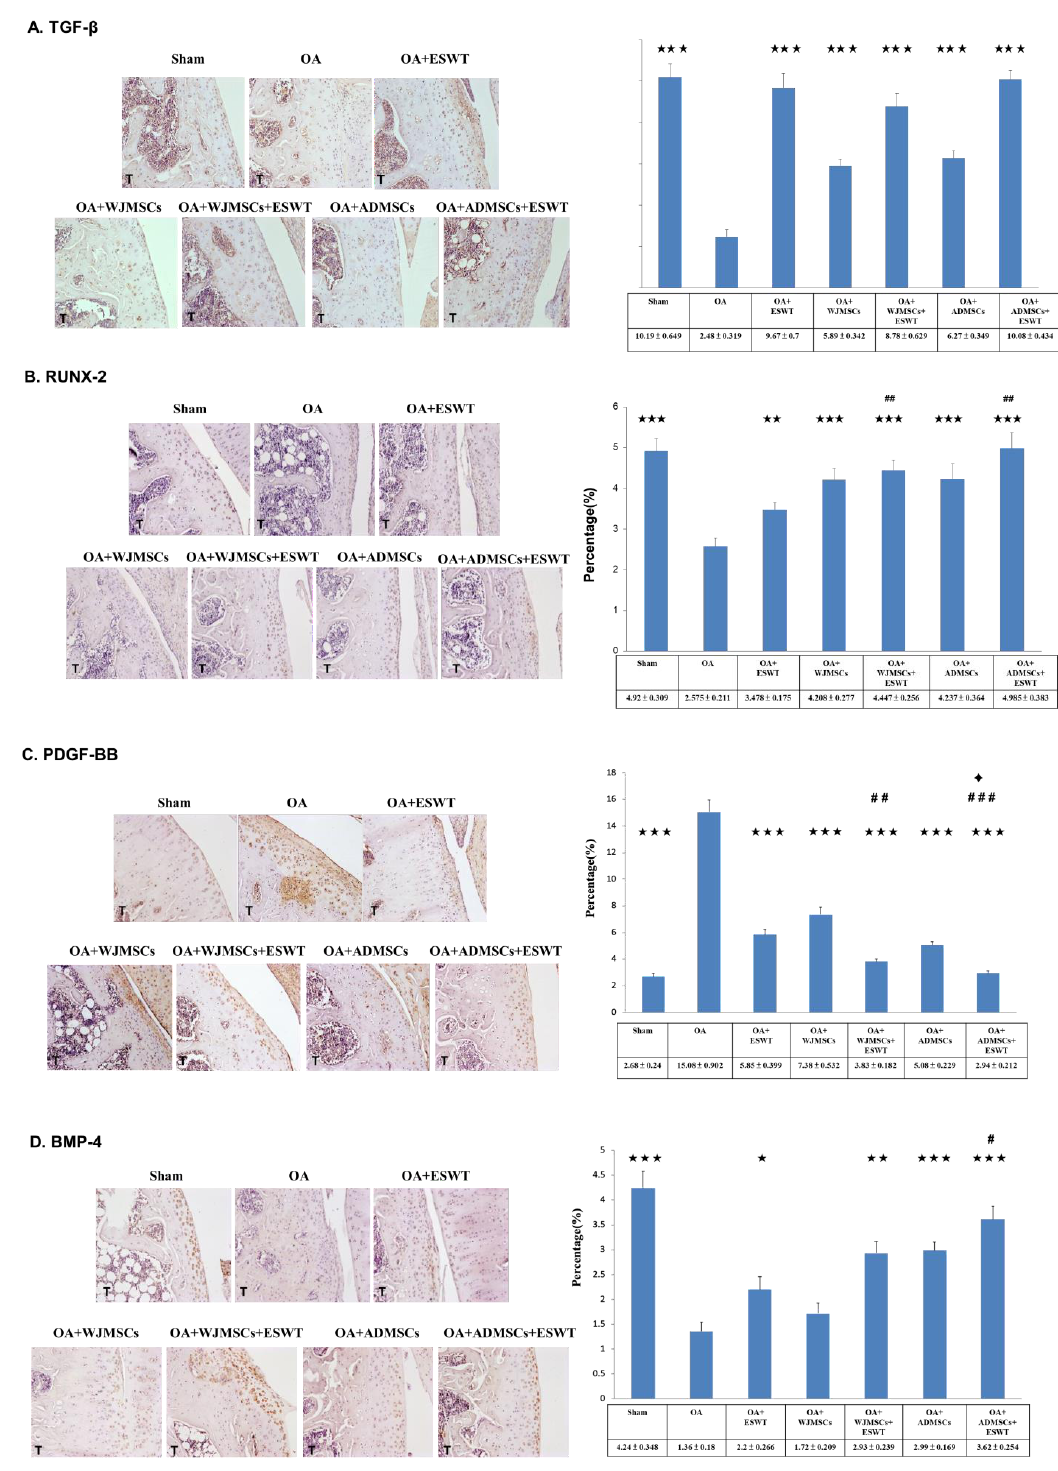
Figure 5. Immunohistochemical analysis for cartilage development-specific markers. ( A ) TGF-β (×200 magnification), ( B ) RUNX-2 (×200 magnification), ( C ) PDGF-BB (×200 magnification), and ( D ) BMP-4 in the experiments (×200 magnification) (left), and levels of expression measured after treatment (right). * p < 0.05, ** p < 0.01, and *** p < 0.001 were compared with OA; # p < 0.05, ## p < 0.01, and ### p < 0.001 were compared among treatment groups. (cid:70) p < 0.05 was compared between ESWT and combined ADMSCs or WJMSCs. n = 6 for all groups. T indicates the